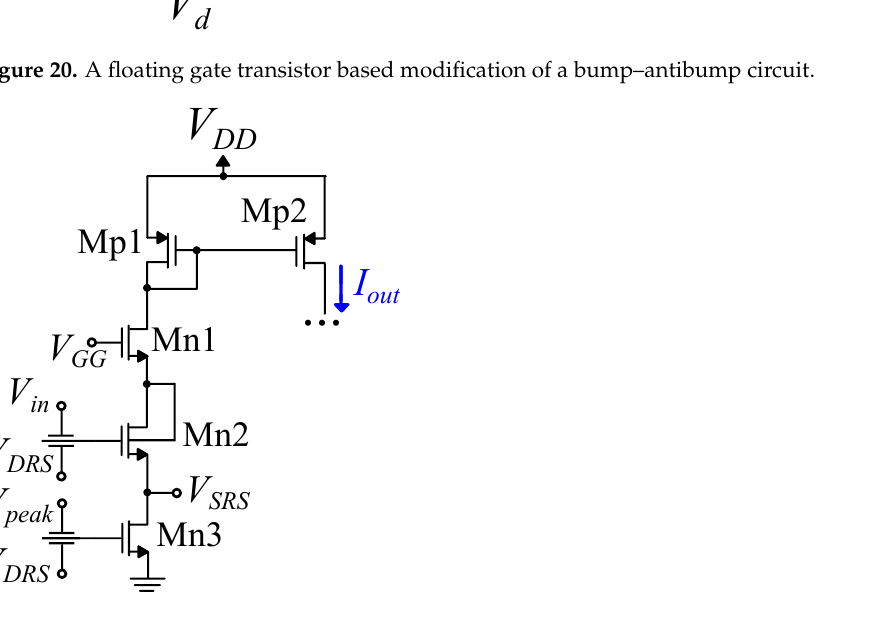
Figure 21. A modification of an exponential-based Gaussian function circuit, using floating gate